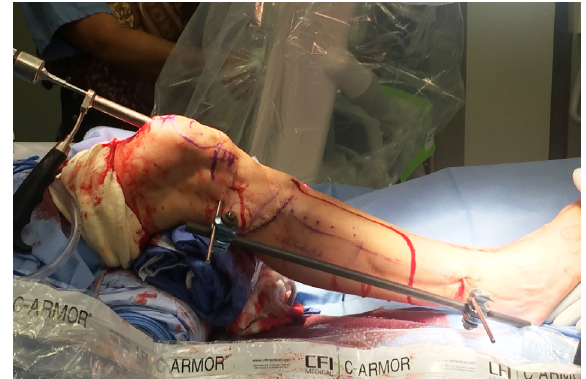
maintain the reduction of the deformity correction after osteotomy during reaming. A suprapatellar approach was used in this